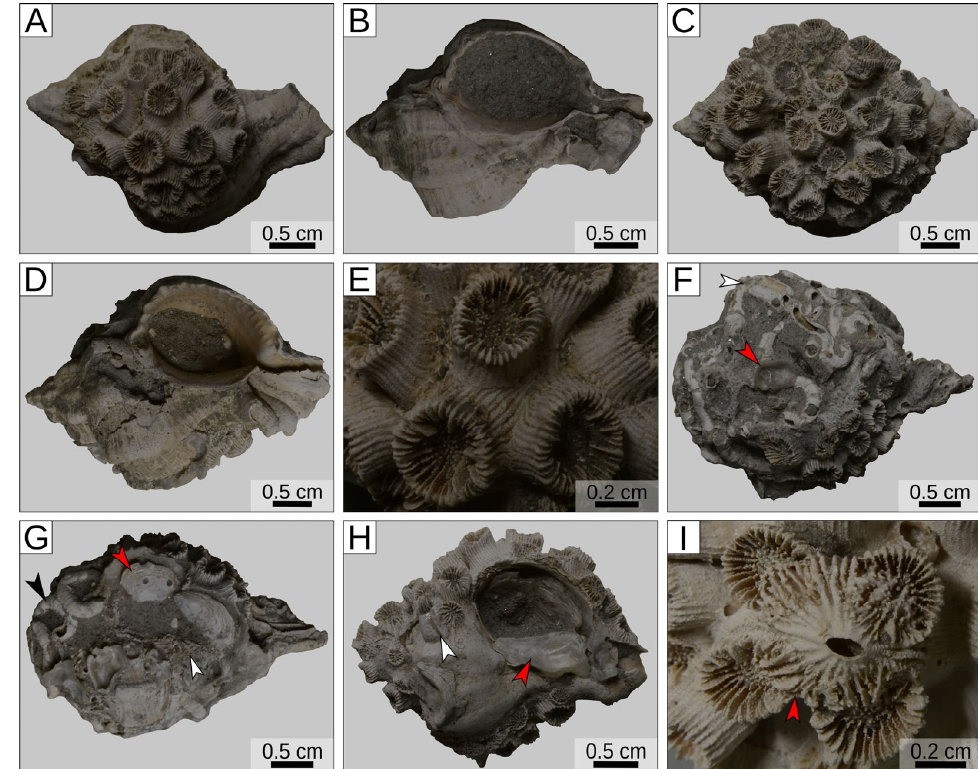
Figure 3. Pliocene coral ‐ encrusted muricids from La Serra. ( A ) Abapertural view of a well ‐ preserved specimen (GAMPS 1055a, b). ( B ) Apertural view of the same specimen as in panel ( A ). ( C ) Abapertural view of another well-preserved specimen (GAMPS 1056a, b) exhibiting a large coral cover and some limited damage on the apertural side. ( D ) Apertural view of the same specimen as in panel ( C ); note the well-preserved aspect of the shell material in the body chamber as well as the lack of sclerobionts therein. ( E ) Detail of the Cladocora caespitosa corallites from the specimen depicted in panels ( A , B ). ( F ) Abapertural view of a poorly preserved specimen (GAMPS 1057a, b); white arrowhead indicates serpulid worm tubes; red arrowhead indicates an oyster. ( G ) Apertural view of the same specimen as in panel ( F ); note the almost completely occluded aperture; red arrowhead indicates a borehole in an oyster located within the aperture; black arrowhead indicates a serpulid worm tube. ( H ) Apertural view of another poorly preserved specimen (GAMPS 1058a, b, c); red arrowhead indicates an oyster growing within the aperture; white arrowhead indicates an acorn barnacle that encrusts the shell and is partially overgrown by a corallite. ( I ) Close ‐ up of a pyrgomatid barnacle growing over the C . caespitosa corallites that encrust the muricid specimen of panel ( H ); red arrowhead indicates where the external ridges of the barnacle merge with the septa of the coral.